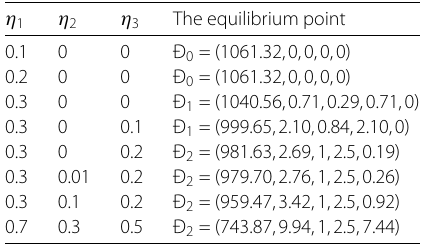
Table 3 Effect of the infection parameters η i , i = 1,2,3, on HIV dynamics